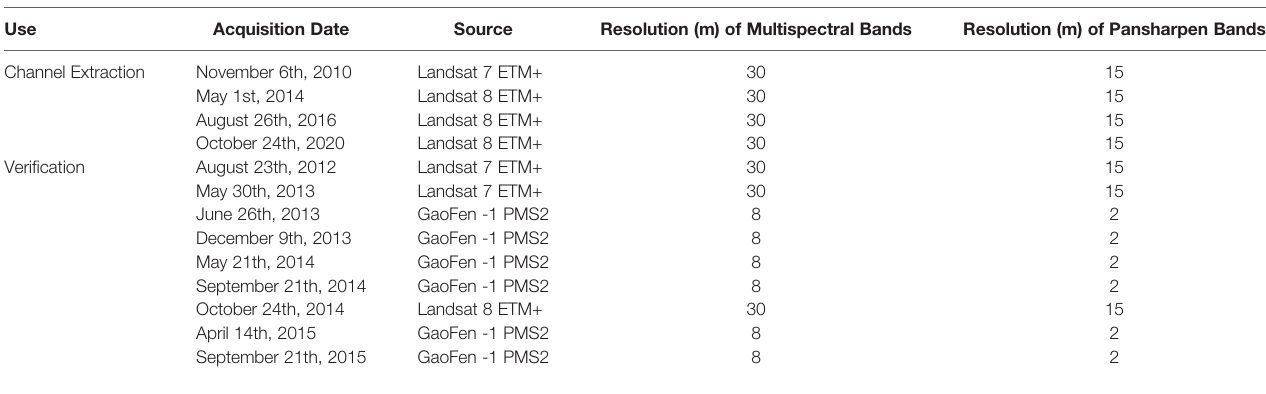
TABLE 1 | Characteristics of the selected remote sensing